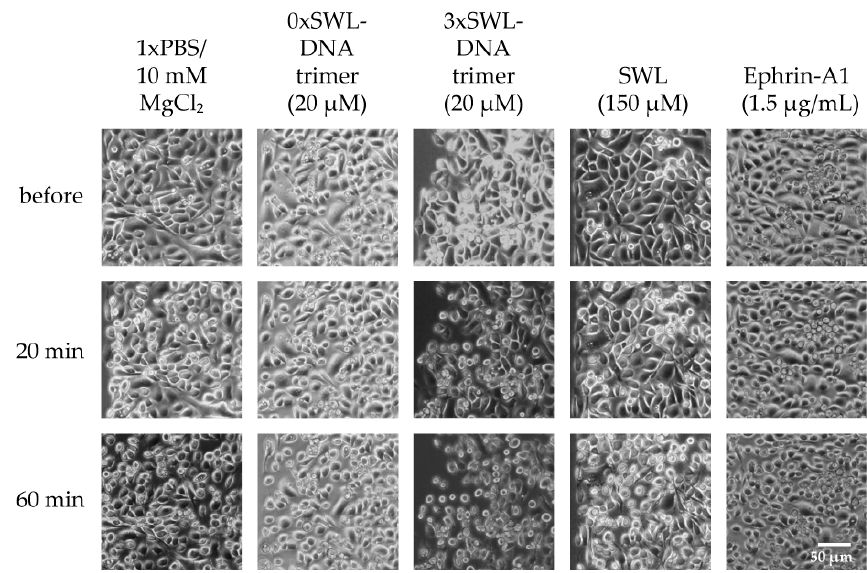
Figure 5. PC-3 cell rounding. Cells were seeded the day before and serum-starved for 4 h prior treatment. Samples were diluted in PBS and incubated on cells for indicated times. Cell morphology was observed and 20 and 60 min to account for inherent rounding effects from serum starvation.